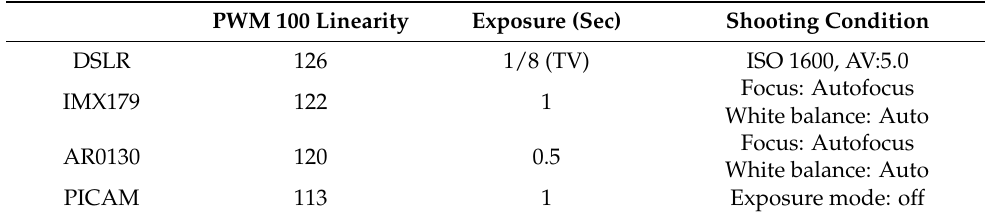
Table 2. Camera shot initial conditions.